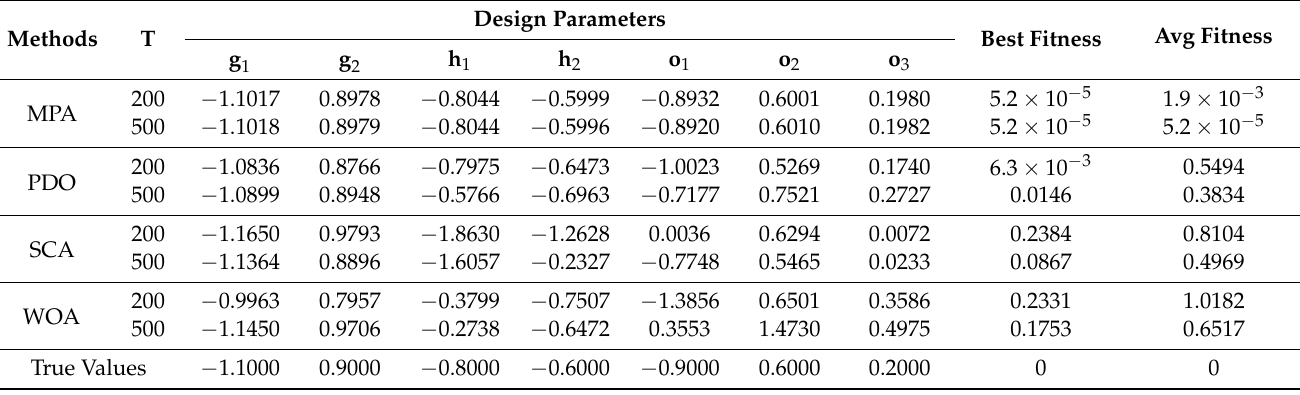
Figure 12. Statistical comparison of MPA with PDO, SCA, and WOA at Np = 50 and T = 200 for case study 2. Table 7. Estimated weight analysis w.r.t generations at a 0.01 noise level for case study 2.